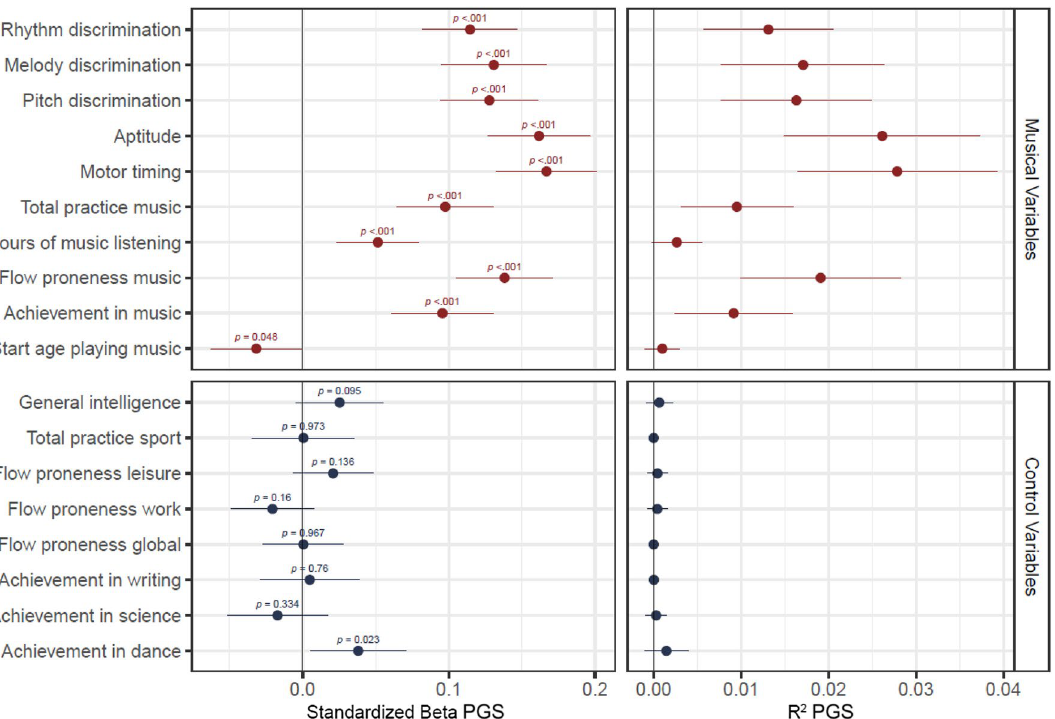
Figure 1. Effects of the PGS rhythm on music-related variables and control phenotypes. The association between PGS rhythm and start age playing music indicates that a higher PGS rhythm is associated with starting to play music at a younger age.